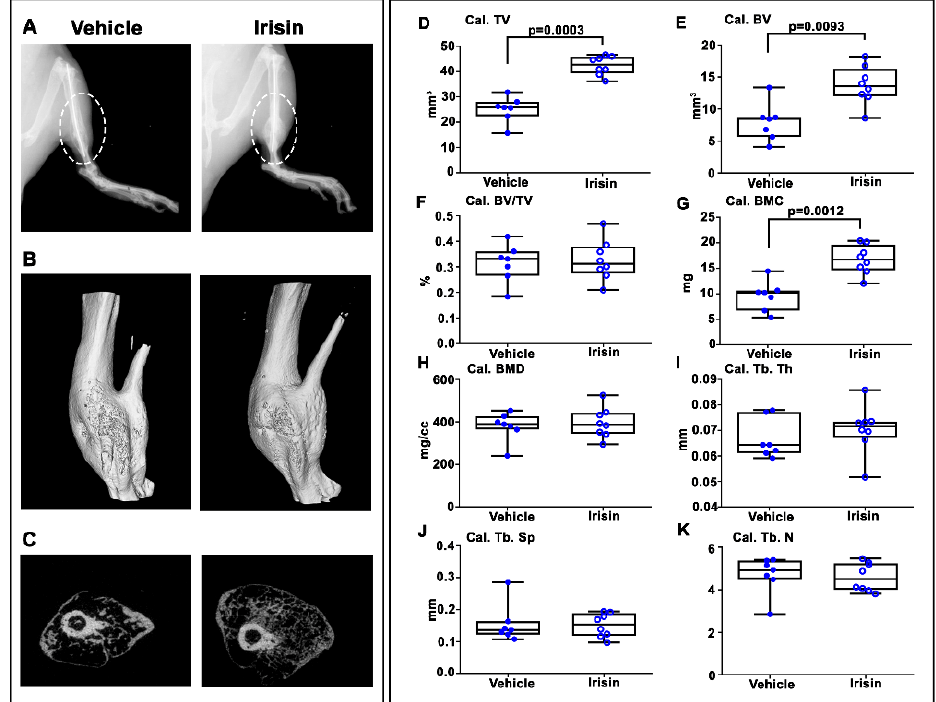
Figure 3. Mice sacrificed at 28 days post-fracture. ( A ) Representative radiological images. ( B ) Longitudinal and ( C ) cross-sectional micro-computed tomography (µCT) 3D reconstructions of fractured tibiae from vehicle- and irisin-treated mice at 28 days post-fracture. µCT analysis of the bone callus: ( D ) Cal. TV= callus total volume; ( E ) Cal. BV= callus bone volume; ( F ) Cal. BV/TV= callus bone volume/total volume; ( G ) Cal. BMC= callus bone mineral content; ( H ) Cal. BMD = callus bone mineral density; ( I ) Cal. Tb. Th= callus trabecular thickness; ( J ) Cal. Tb. Sp= callus trabecular separation; ( K ) Cal. Tb. n = callus trabecular number. Vehicle-treated mice ( n = 7); irisin-treated mice ( n = 8). Data are presented as box-and-whisker plots with median and interquartile ranges, from maximum to minimum, with all data points shown. The Mann–Whitney test was used to compare groups.